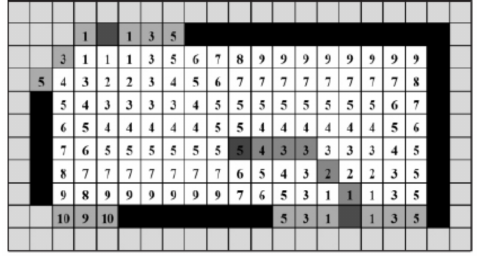
Figure 4. Exploration transform and the global